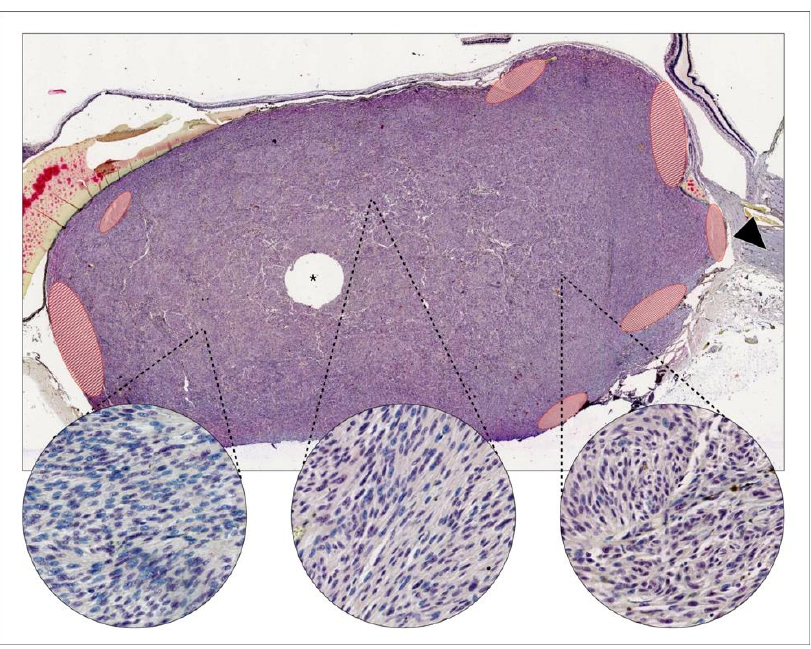
Figure 1. Example of intratumor heterogeneity in BRCA1 associated protein 1 (BAP-1) expression. In a uveal melanoma growing close to the optic nerve head (arrowhead), both BAP-1 positive and negative cells can be identified. Positive nuclei are stained lilac with a red chromogen over blue hematoxylin. Negative cells are stained with blue hematoxylin only. Areas with relatively low (left circle), intermediate (center circle) and high (right circle) proportions of BAP-1 positive cells can be found. Areas with artefacts, uneven staining, necrosis, bleeding, abundant pigmentation or poor focus were excluded from analysis (red-striped areas). Tissue for gene expression classification has been removed from the center of this tumor (asterisk). This case was designated class 1A, implying a low risk for metastasis. Magnification × 20, circles ×